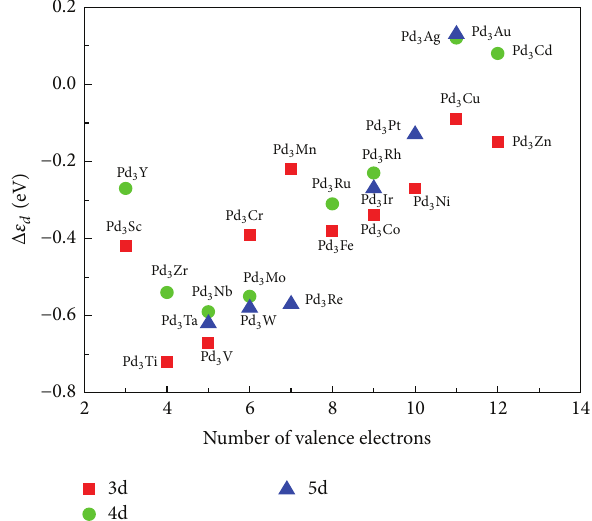
Figure 7: The relationship between the calculated 𝑑 -band center, 𝜀 𝑑 , and number of valence electrons in M, Δ𝜀 𝑑 = 𝜀 𝑑 ( Pd